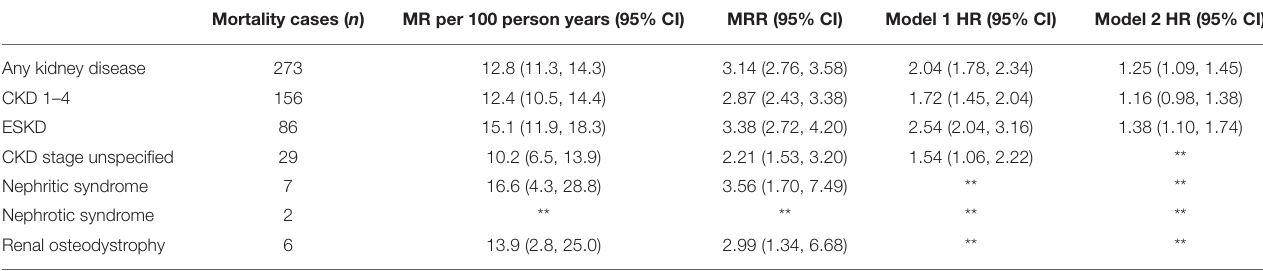
TABLE 2 | Mortality rate (MR), MR ratio (MRR) * , and adjusted hazard ratio (HR) * of mortality for each kidney disease among adults with cerebral palsy ( n = 16,728). Mortality cases ( n